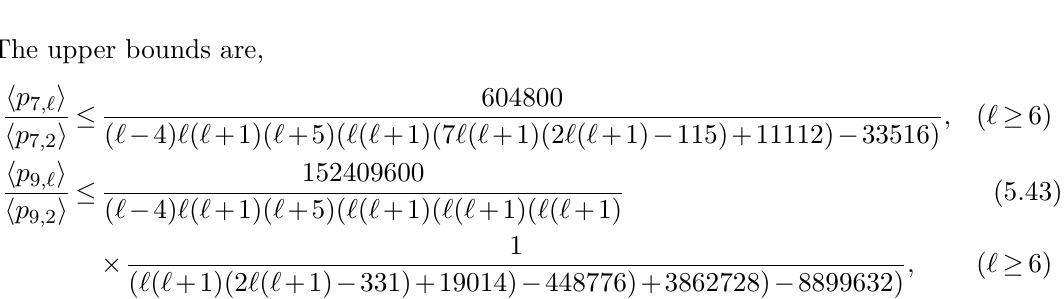
Figure 10 . Here we compare the different k level upper bounds of h p k,‘ i with the S -matrix 1 ( s − M 2 )( t − M 2 )( u − M 2 )